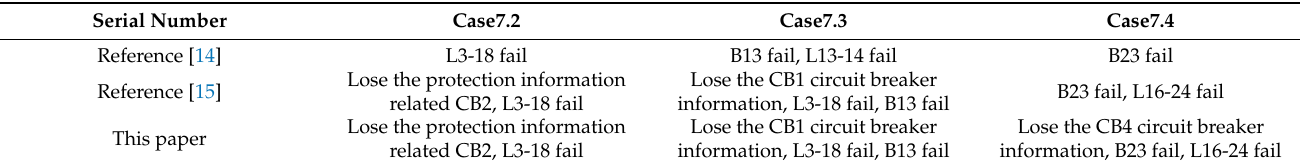
Table 10. Comparison of specific cases among different